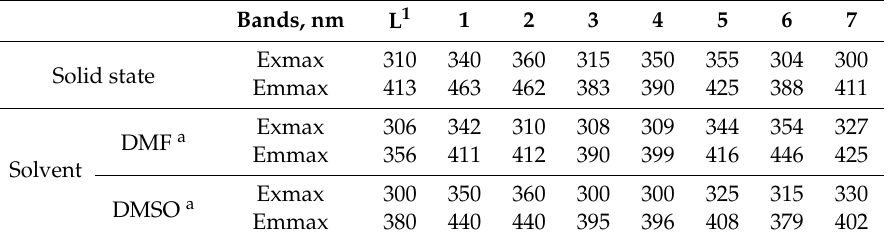
Figure 10. Solid state emission spectra of L 1 and complexes 1 – 7 at room temperature (the determination of compound 4 was run with a small amount of samples, a few mg, and under conditions of the narrow slits of emission and excitation than other compounds). The peak of emission is 413 nm for L 1 , 463 ( 1 ), 462 ( 2 ), 383 ( 3 ), 390 ( 4 ), 425 ( 5 ), 388 ( 6 ), 411 ( 7 ), respectively. Table 3. Photoluminescent properties of the compounds in solid state and solution.